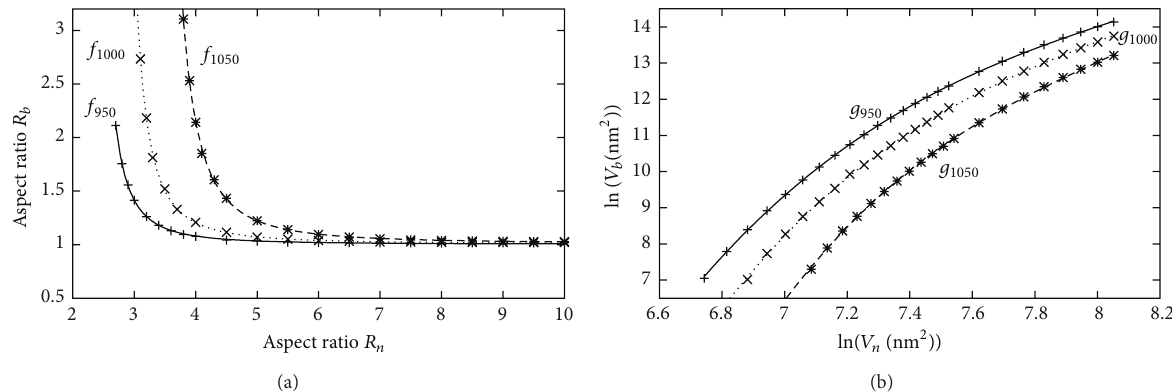
Figure 4: Evolution of (a) the aspect ratio of the bubble 𝑅 𝑏 as function of the aspect ratio of the nanowire 𝑅 𝑛 for the three wavelengths and (b) evolution of the volume of the bubble 𝑉 𝑏 as function of the volume of the nanowire 𝑉 𝑛 .